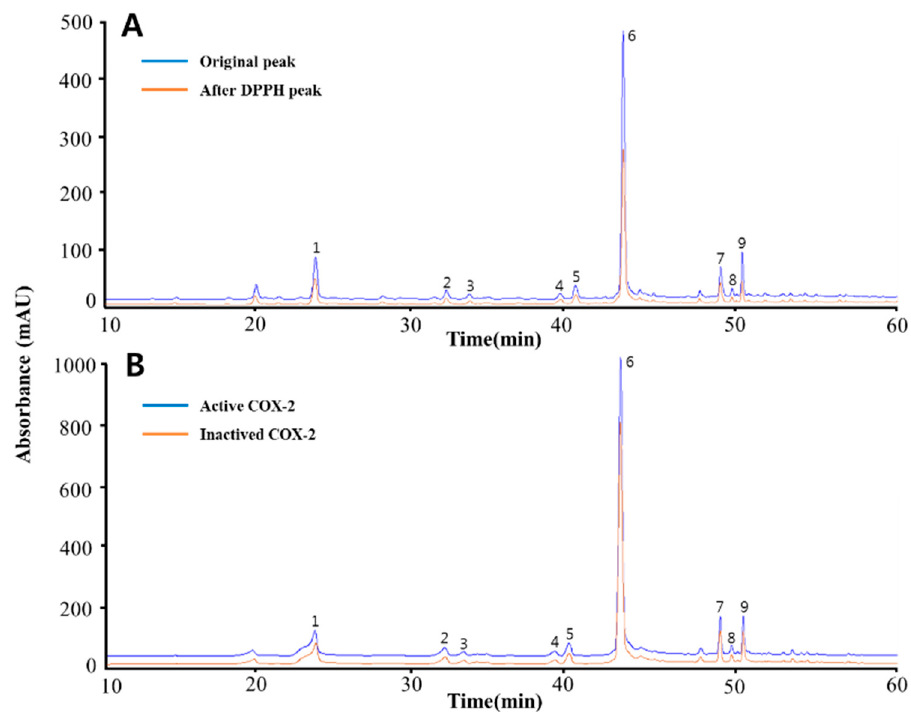
Figure 1. The HPLC chromatograms of the phenolic compounds in Gynura procumbens. The blue line in ( A ) is the original chromatogram at the beginning of the Gynura procumbens , while the orange line is the chromatogram after reacting with DPPH. The blue line in ( B ) is a chromatogram of the phenolic compound after reacting with activated COX-2, while the orange line is the chromatogram after reacting with inactivated COX-2. The detected compounds at the 284nm wavelength are chlorogenic acid (1), oxypeucedanin (2), isoimperatorin (3), indol-3-carboxylic acid (4), kynurenic acid (5), caffeic acid (6), coumaric acid (7), lutein (8) and luteolin (9). Table 1. The HPLC-MS/MS data of polyphenols from Gynura procumbens. Peak No.